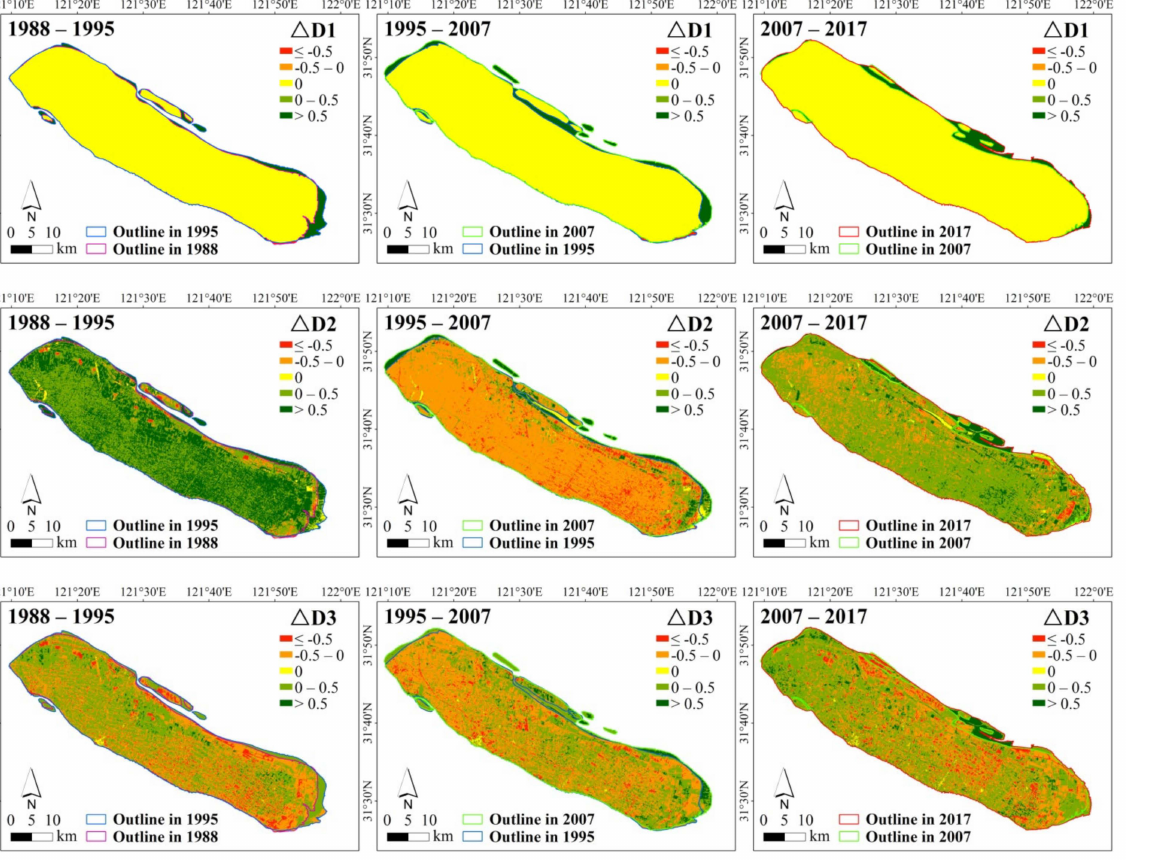
Figure 5. Spatial distributions of variations of the disturbances across different years: D1: disturbance 1, i.e., geomorphological change; D2: disturbance 2, i.e., soil salinization; D3: disturbance 3, i.e., human influence. ∆ D indicates the variation of one disturbance across a time